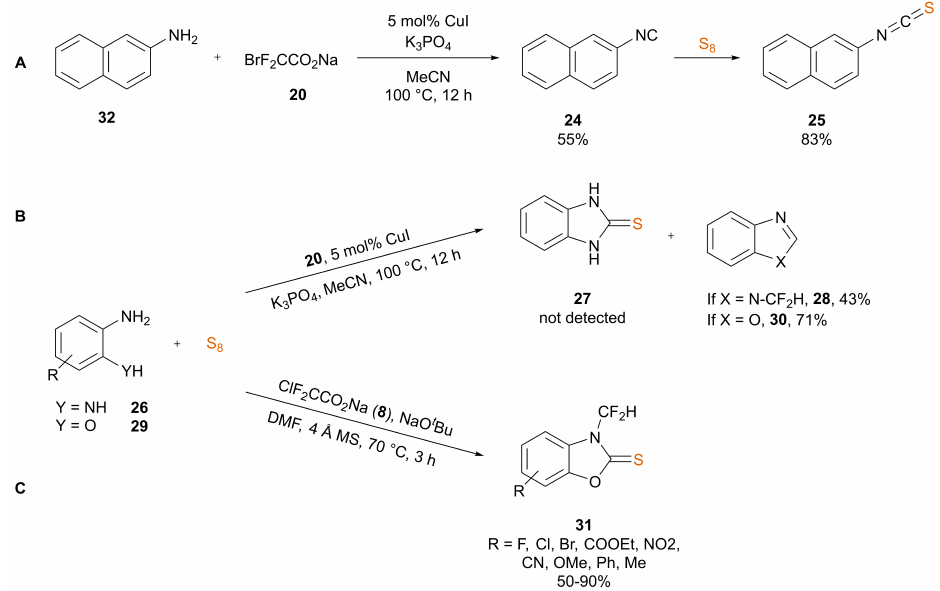
Scheme 6. Control reactions for the proposed mechanistic pathways of the Zhang and Feng ([62]) synthesis ( A , B ). Reaction of ortho -hydroxy anilines with sulfur and difluorocarbene by Weng ([52], ( C )). ( A , B ) are based on Schemes 2 and 4 from